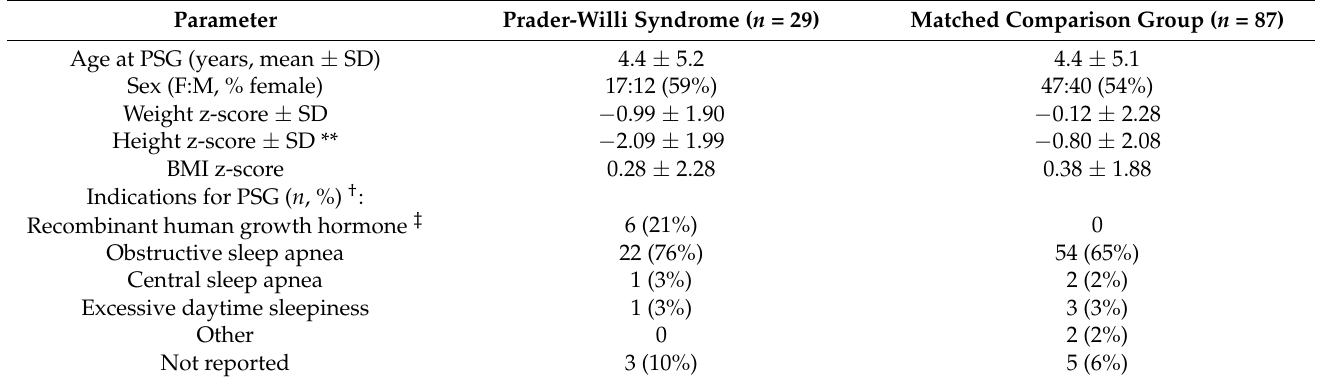
Table 1. Demographic characteristics of children with PWS and the matched comparison group.